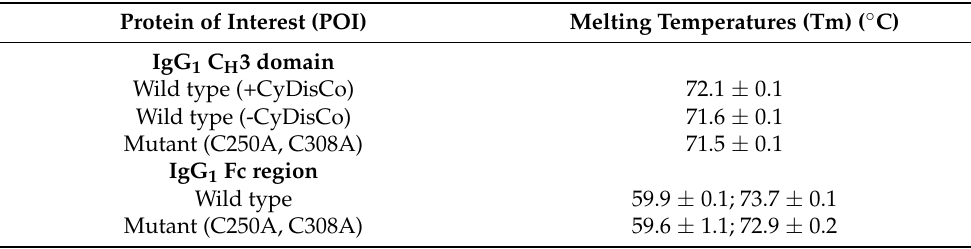
Figure 5. Thermal stability of purified proteins using Nano Differential Scanning Fluorimetry (nanoDSF). ( A ) Thermal stability of partially oxidized wild type IgG 1 C H 3 domain produced with CyDisCo (black), reduced wild type IgG 1 C H 3 domain (red) and IgG 1 C H 3 domain (C250A, C308A) (blue). A single unfolding event can be observed at the same temperature suggesting no influence of the mutation on thermal stability or dimerization of the C H 3 domain. ( B ) Thermal stability of wild type IgG 1 Fc region (black) and IgG 1 Fc region (C250A, C308A) (red). Two thermal unfolding events can be observed with the peak at the higher temperature corresponding to the unfolding of the C H 3 domain. No significant influence of the mutation on thermal stability was observed. Table 3. Thermal stability analysis of wild type and mutant IgG 1 C H 3 domain and IgG 1 Fc region using